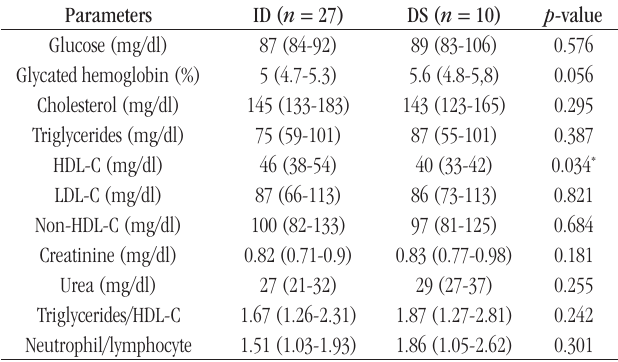
taBLE − Biochemical parameters, triglyceride/HDL-C and neutrophil/lymphocyte ratios in the groups ID and DS